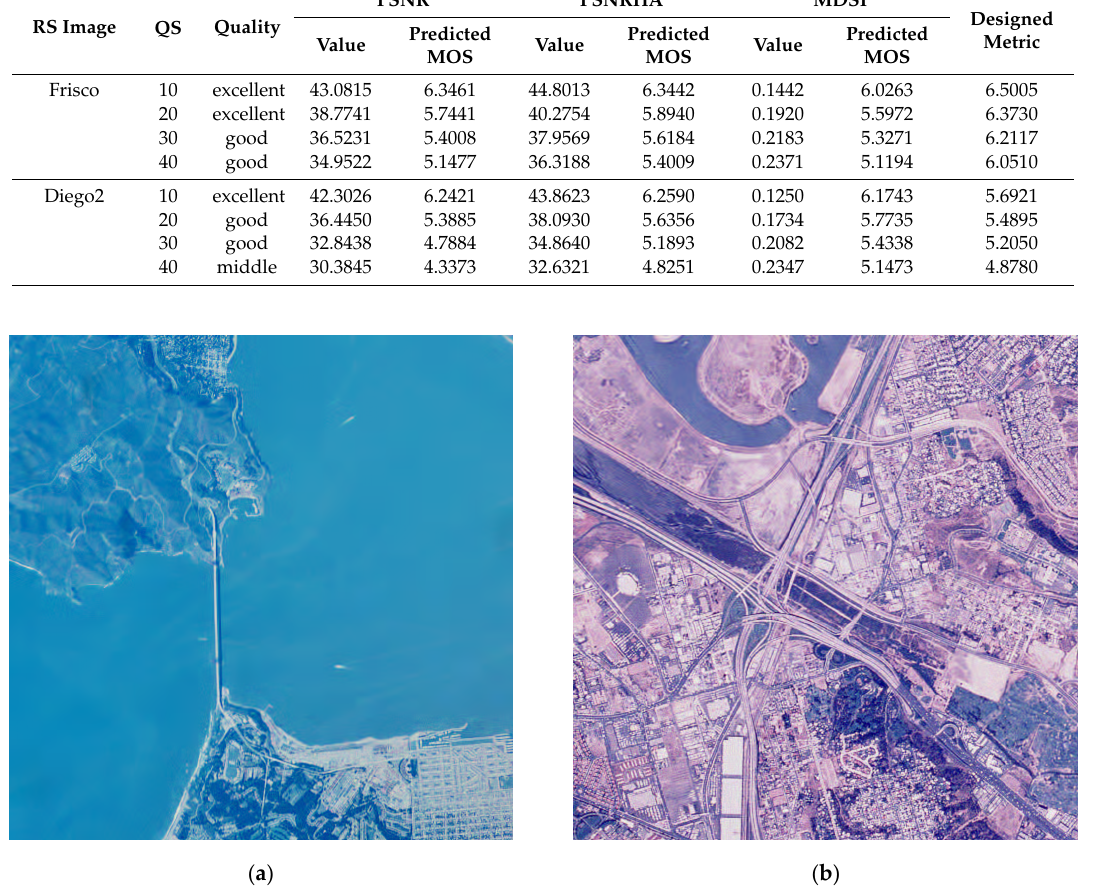
Figure 10. Compressed images with quantization step (QS) = 40: ( a ) Frisco; ( b ) Diego2.